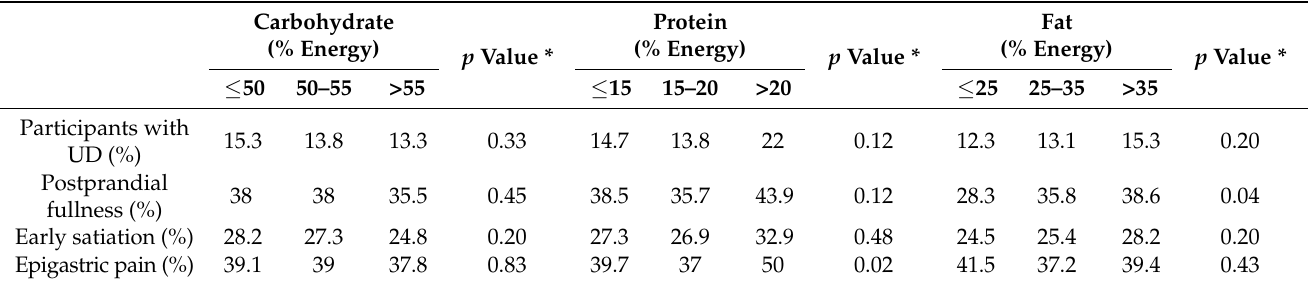
Table 3. Prevalence of uninvestigated dyspepsia and its symptoms in relation to macronutrient